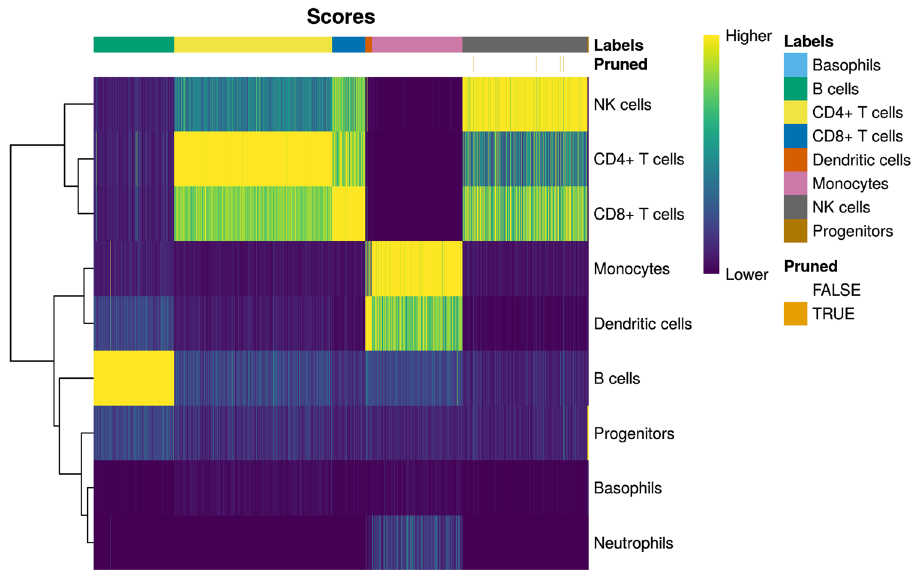
Fig. 8 Heatmap showing SingleR scores for cells in the RA PBMC dataset computed against the Monaco immune reference 36 . Higher score indicates greater likelihood of the cell being of that corresponding cell type. Cells pruned by SingleR are indicated in orange.